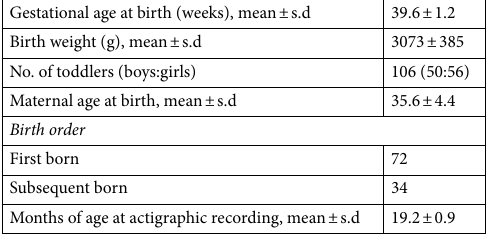
Table 1. Characteristics of participants.